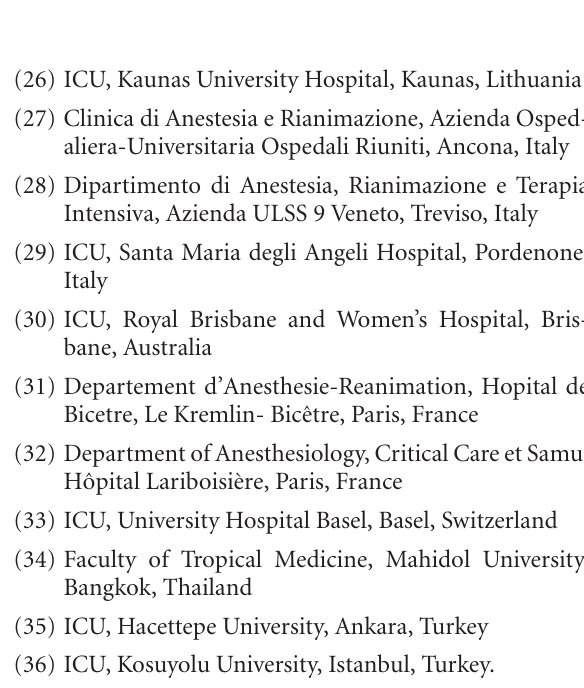
Figure 1: Overview of the ICU’s that were invited to participate in the